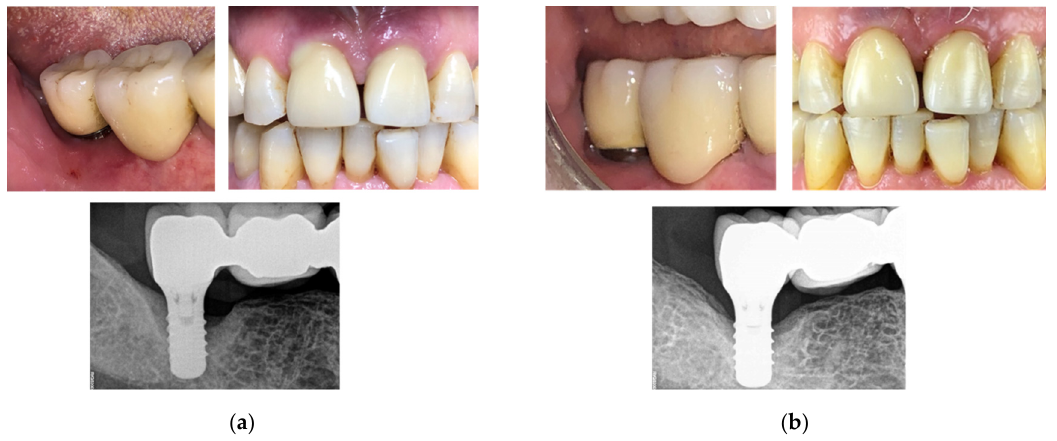
Figure 15. Clinical case No. 3: dental implant ( a ) before and ( b ) after the treatment.